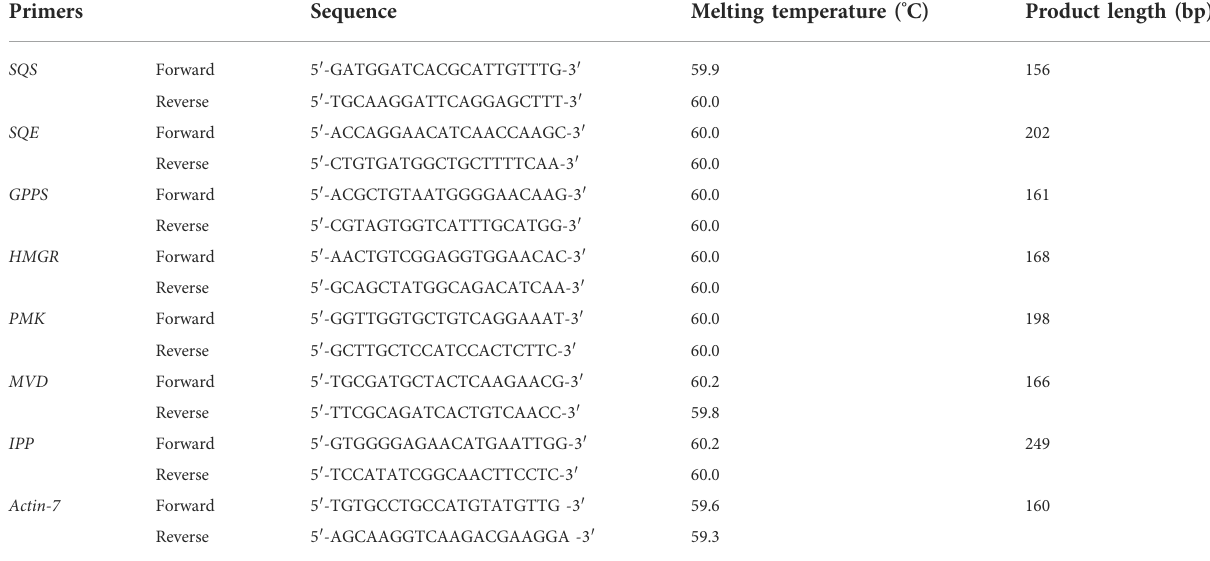
TABLE 1 Properties of primers used in real-time PCR reaction.